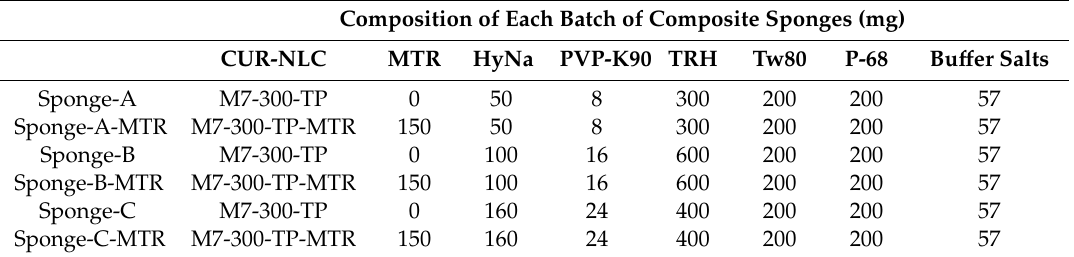
Table 4. Nanocomposite sponge compositions.